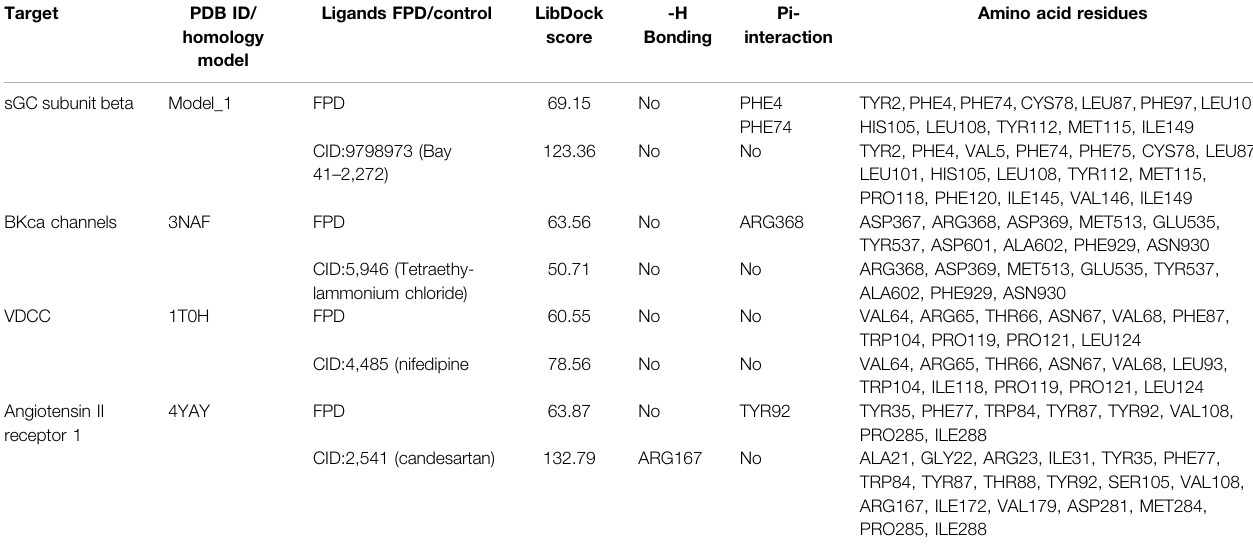
TABLE 2 | LibDock scoring functions, hydrogen bonding, Pi-interaction, and active binding site residues observed in the in silico docking studies of FPD with selected